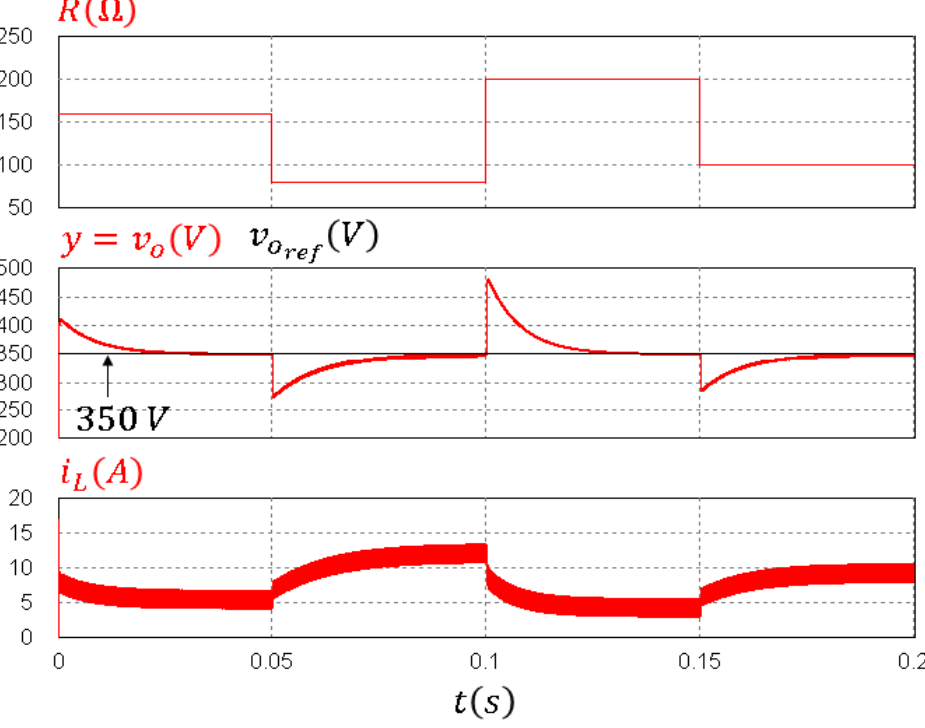
Figure 4. Response to increasing and decreasing variations of the output